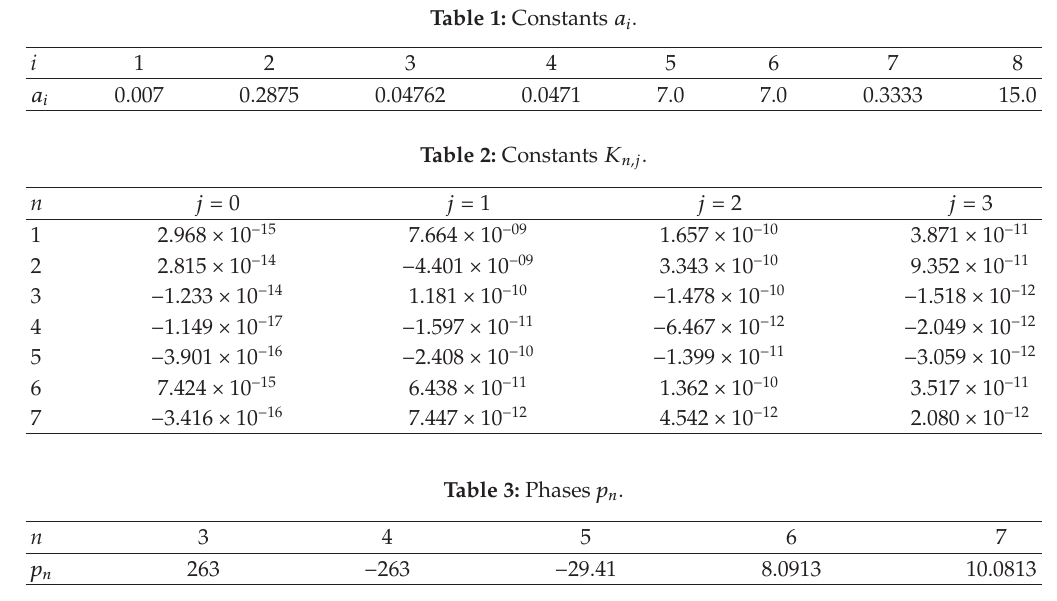
Table 1: Constants a